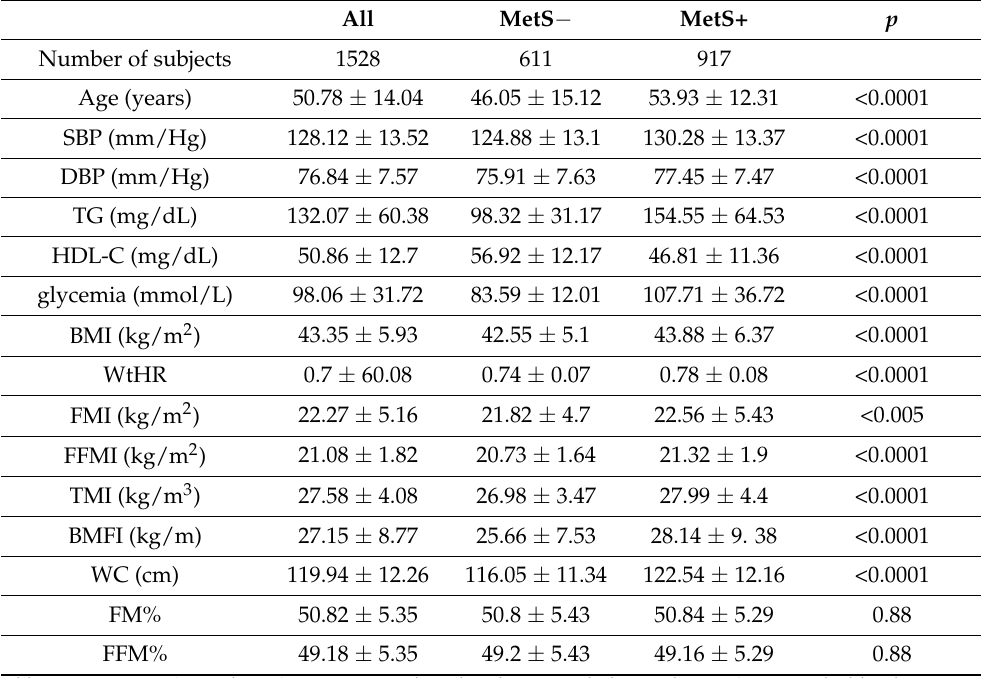
Table 1. Descriptive statistics for all subjects, MetS − , and MetS+. Data are presented as mean ± SD. p is the difference between MetS − and